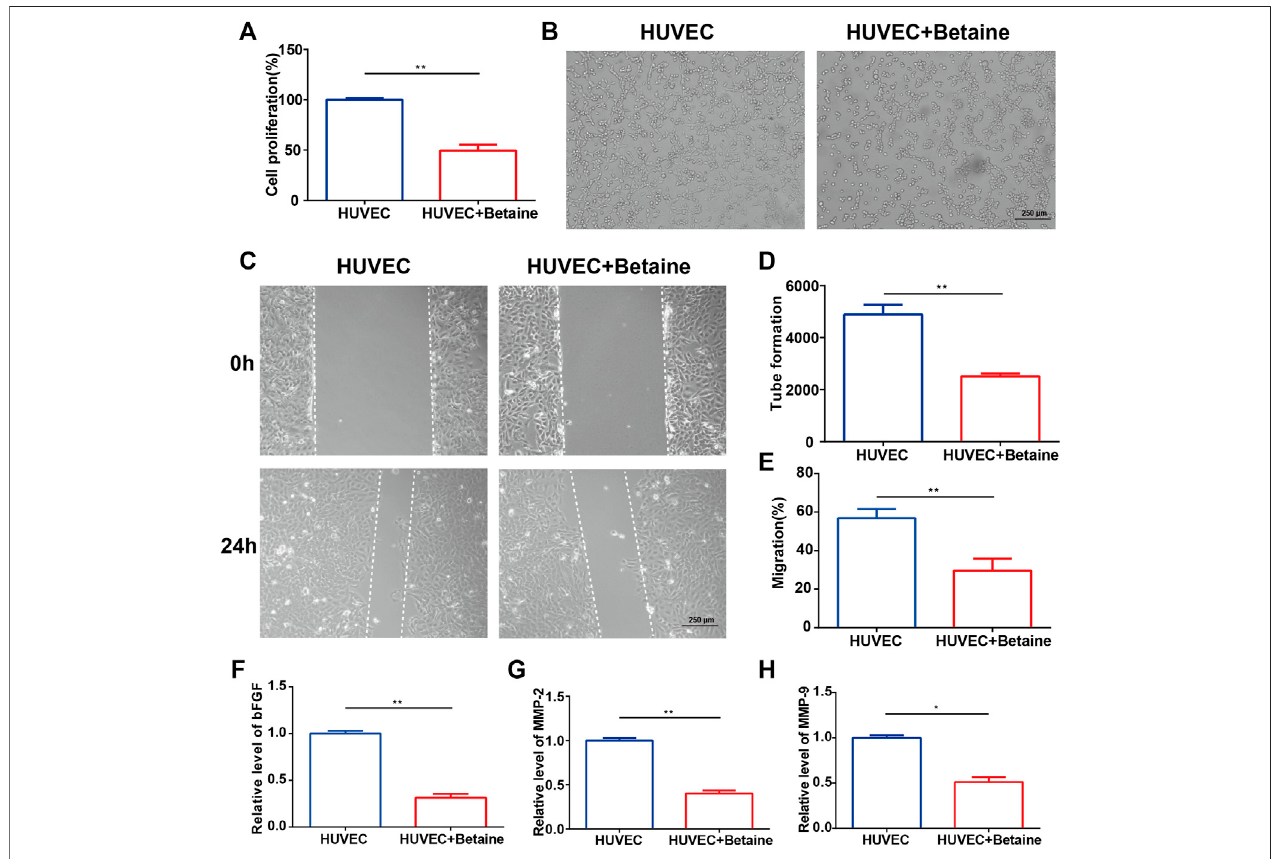
FIGURE5| Betainesuppressesbloodvesselformation invitro . (A) ProliferationofHUVECsindifferentgroups. (B) TubeformationassayofHUVECsfor12 h.Scale bar, 250 μ m. (C) Wounding migration assay of HUVECs for 24 h. Scale bar, 250 μ m. (D) Quantitative analysis of tube formation assay. (E) Quantitative analysis of wounding migration assay. (F – H) The mRNA expression levels of bFGF, MMP-2 and MMP-9. * p < 0.05 as denoted by bar, ** p < 0.01 as denoted by bar.